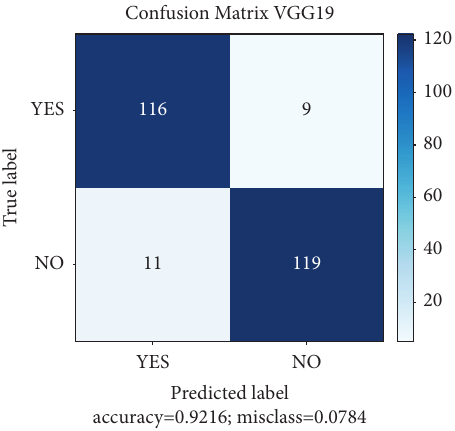
Figure 16: VGG19 network architecture accuracy based on F1-score. Table 5: Accuracy of network architectures based on F1-score.